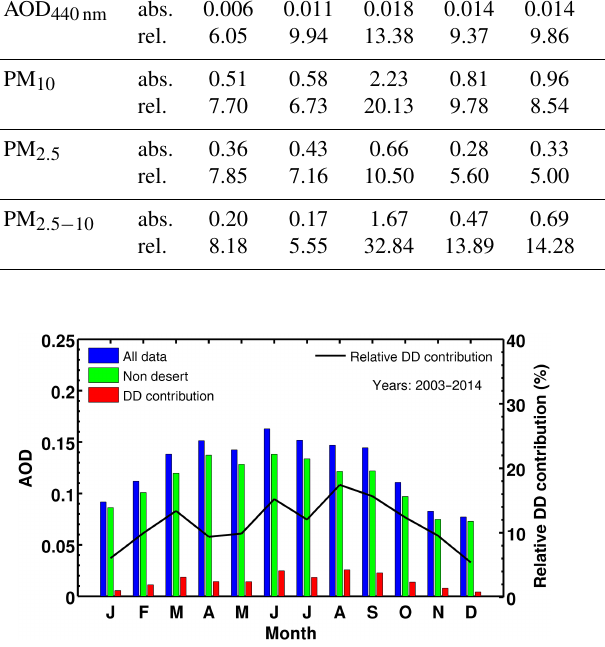
Figure 4. Annual cycle for DD contribution to the total monthly AOD means in absolute (red bar) and relative values (black line) in 2003–2014. Blue bars (also indicated as all data) represent the annual cycle of total AOD and green bars the corresponding values without including the days of desert dust (indicated as non